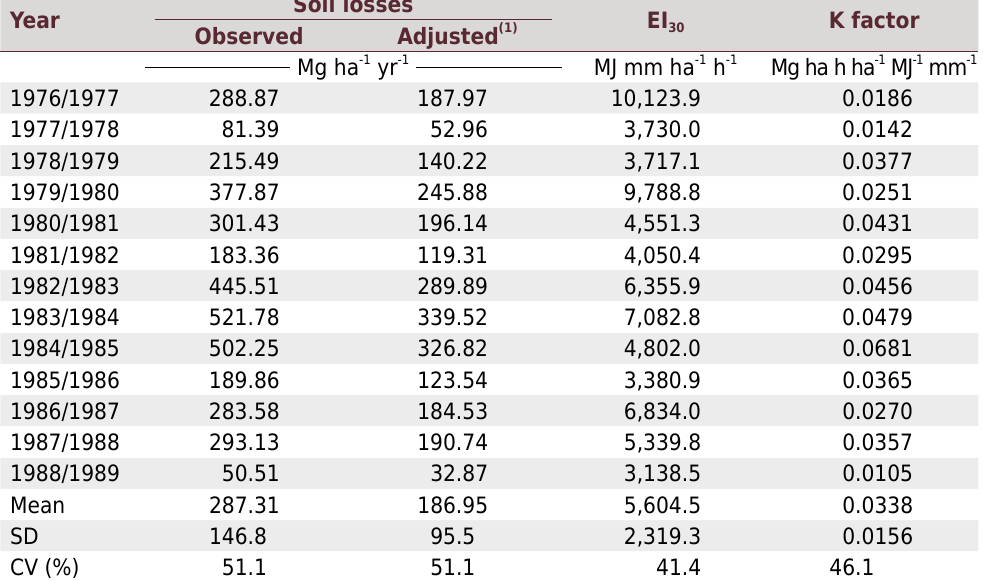
Table 2. Soil losses observed and adjusted to 9 % slope (“ S ” factor = 1.536) in the bare soil treatment (standard plot of the USLE) for determination of the K factor in the 13 years of carrying out the experiment, from 1976/77 to 1987/88 in Eldorado do Sul, RS,